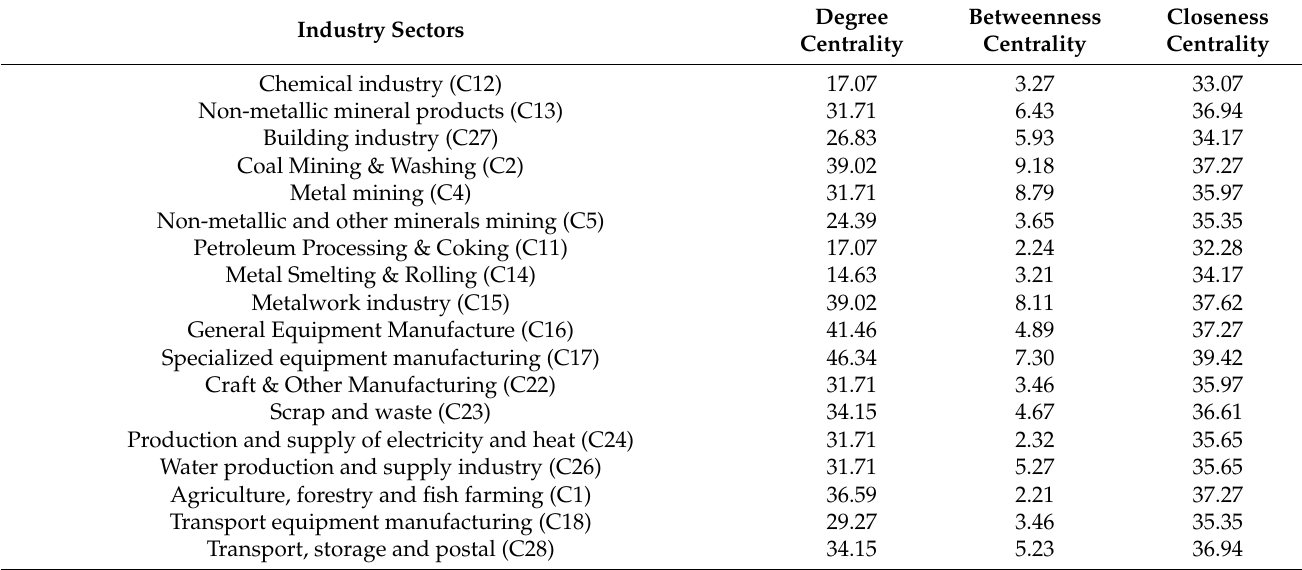
Table 4. Distribution of the values of centrality of 18 industrial sectors in Jilin Province in 2017.